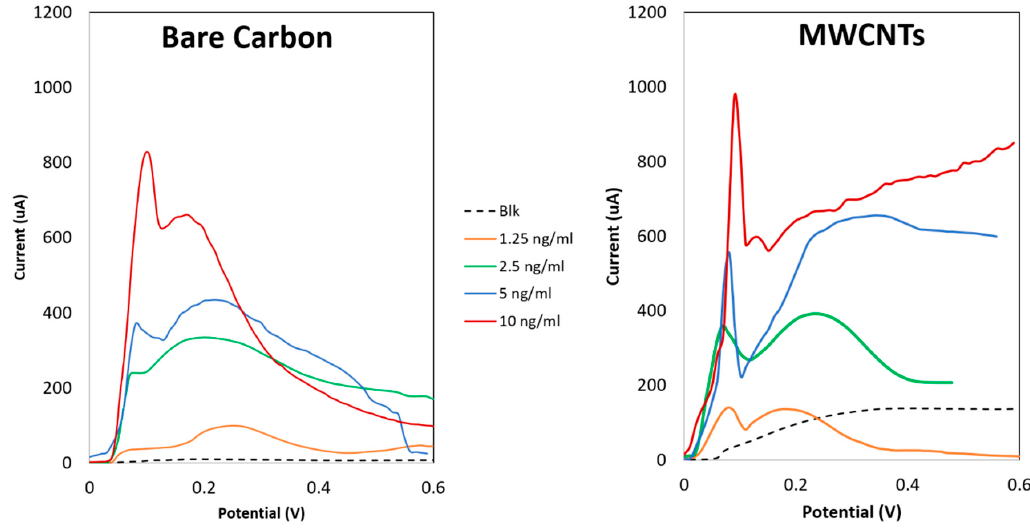
Figure 7. LSV for IL8 quantification performed using bare and nanostructured carbon-based sensors.